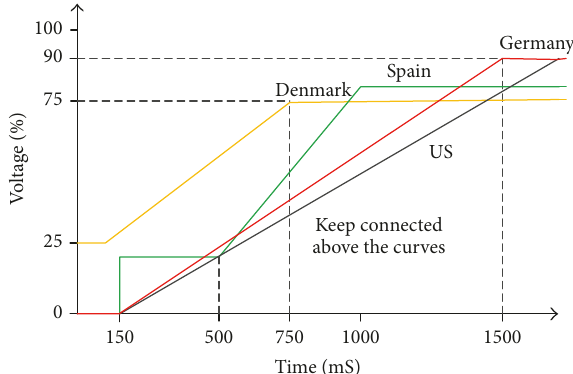
Figure 10: Curves for low-voltage ride-through requirements for different countries [7].